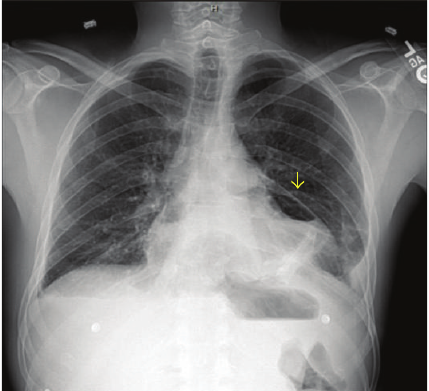
Figure 3: PA chest X-ray. A halo is visible around the left cardiac border.